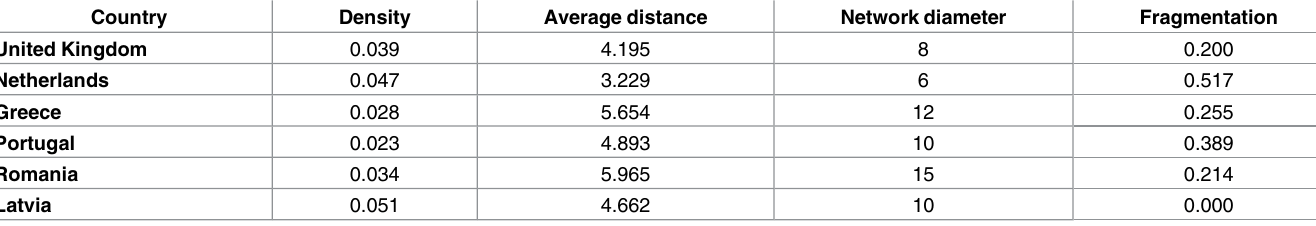
Table 1. Cohesion metrics for six LIFE Nature partnership